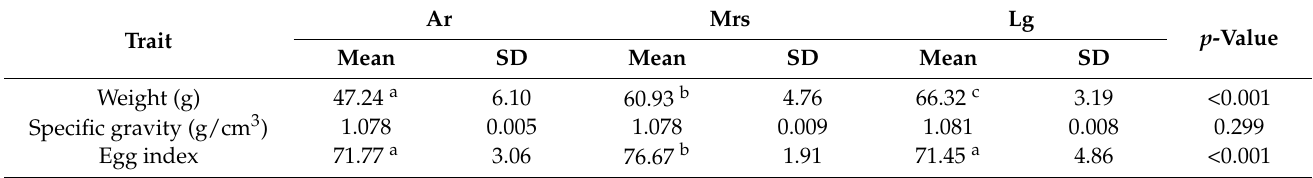
Table 1. The quality traits of the whole eggs from three breeds of hens differentiated by the eggshell color. Trait